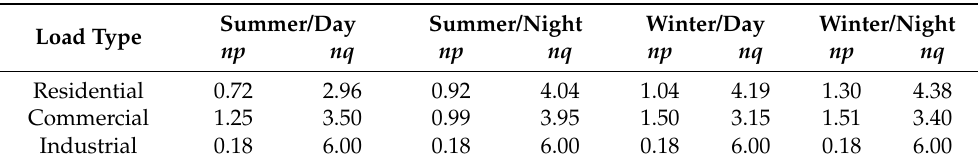
Table 1. Example data for voltage dependent